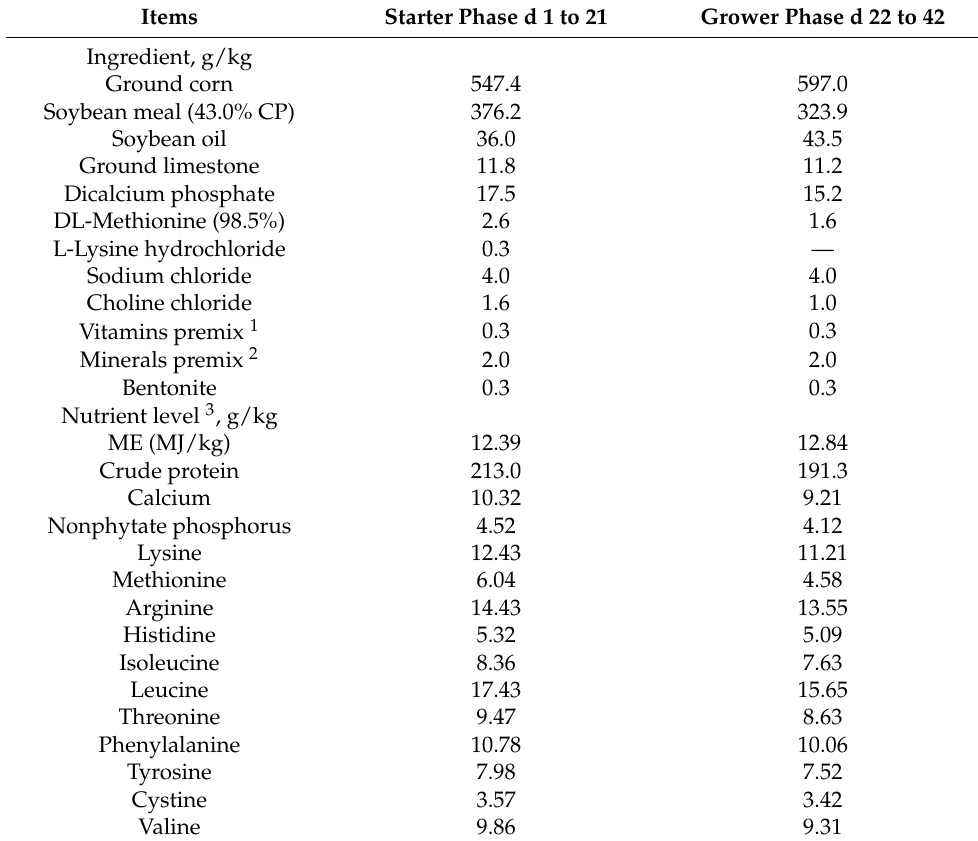
Table 1. Composition and nutrient levels of the basal diets (as